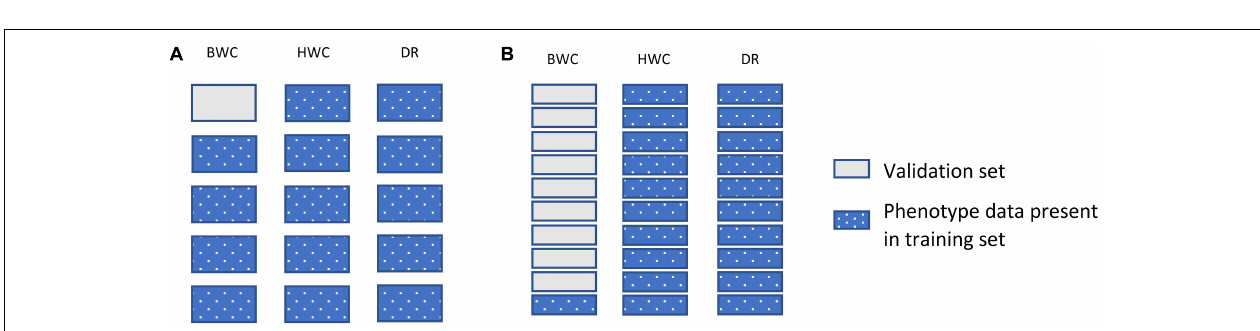
FIGURE 3 | Data used for ST-GBLUP and MT_GBLUP prediction modeling in CV2 (A) and the CV_90 scenario where 90% of the inbred lines were randomly selected and had BWC phenotypes set to missing (B) . Each box indicates the presence or absence of the phenotypic data for a particular trait on either the training or validation set. The presence and absence of phenotypic data are indicated by dotted blue and gray filled, respectively.